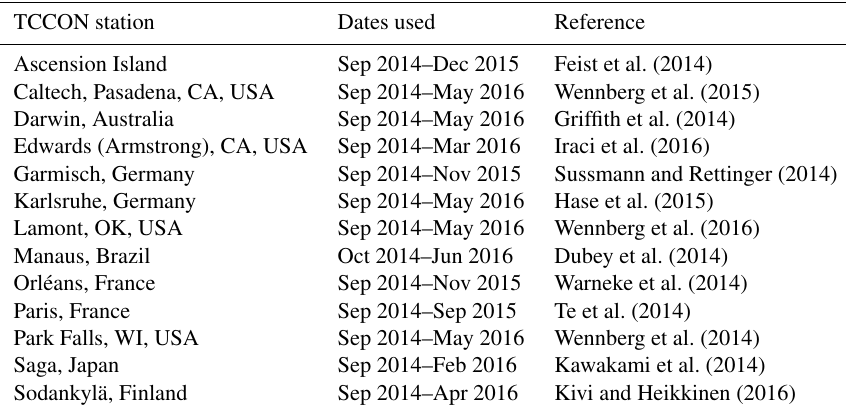
Table 1. TCCON stations used in this study. TCCON station Dates used